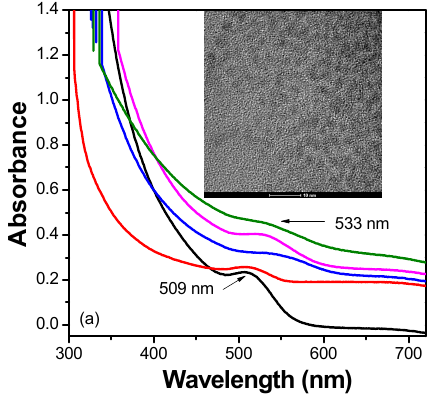
Figure 9. UV–vis absorption spectra of CdTe (black), CdTe/CdS core/shell growth with Cd 2+ :thiourea (S 2– ) molar ratios of 1:1, 1:2, 1:4, and 1:8 (red, blue, magenta, and olive lines, respectively). QDs containing DDT ligand were dispersed in toluene. Inset: TEM micrograph of CdTe/CdS